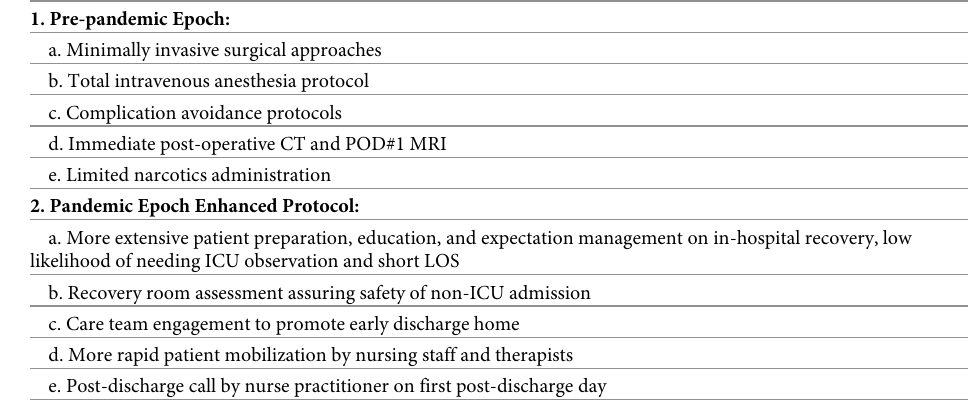
Table 1. Clinical practice protocols promoting less ICU utilization and early